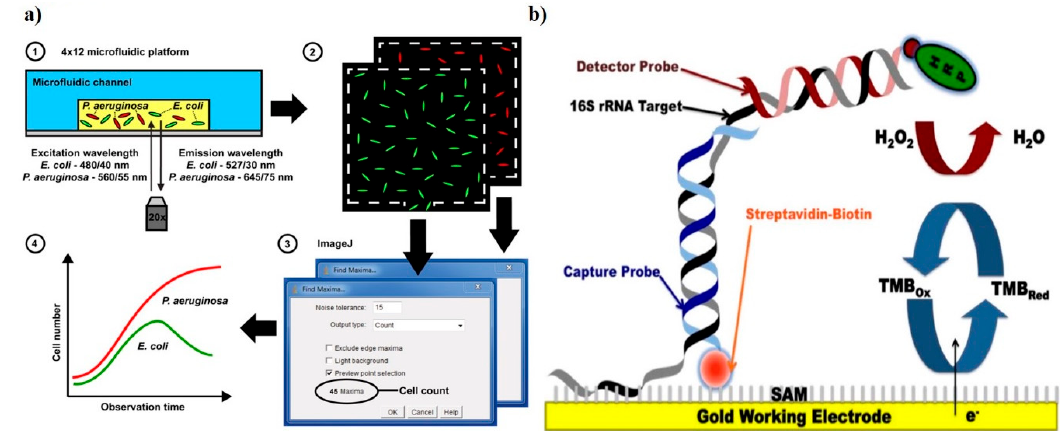
Figure 4. Demonstration of sensors for antibacterial susceptibility testing involving ( a ) an optical microfluidics biosensor, showing optical detection of microbial cultures, reproduced with permission from [83], published by RCS Advances, 2015; and ( b ) an electrochemical biosensor, detection was based on hybridization of the target bacterial 16S rRNA with a detector probe, adapted with permission from Liu [86] (under terms of the Creative Commons attribution license).